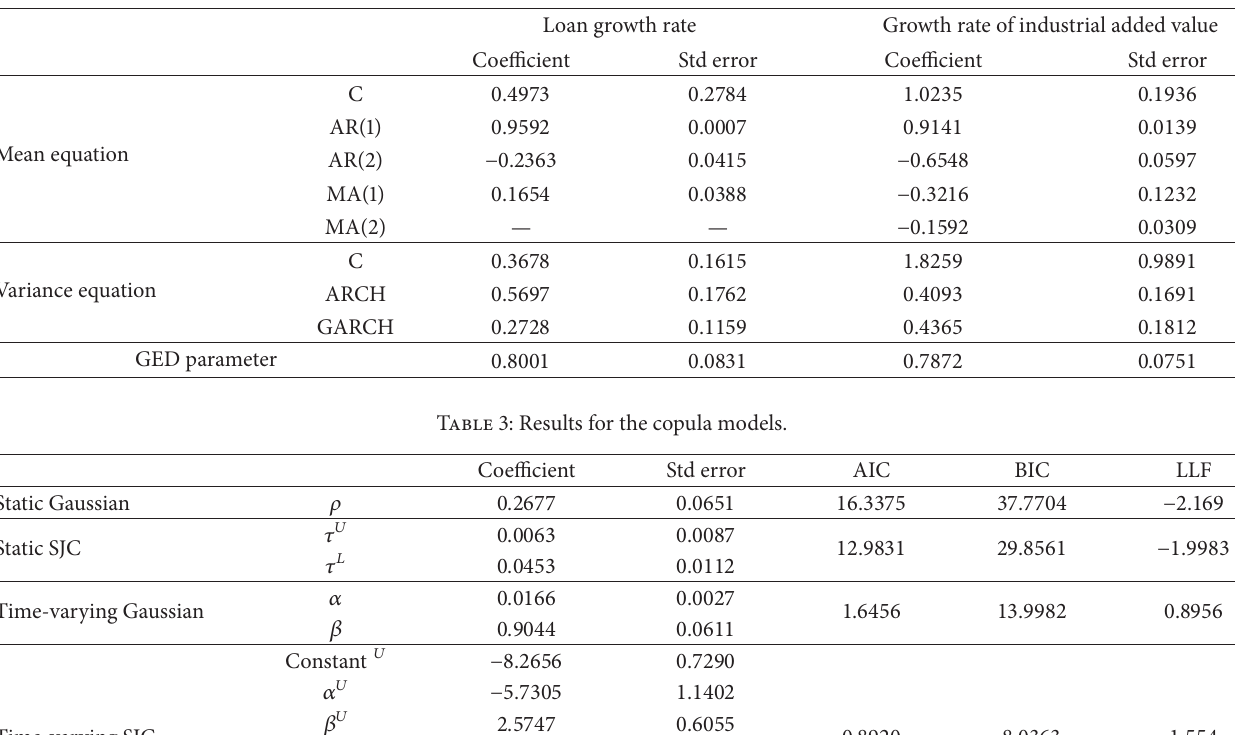
Table 2: Results for the marginal distributions.